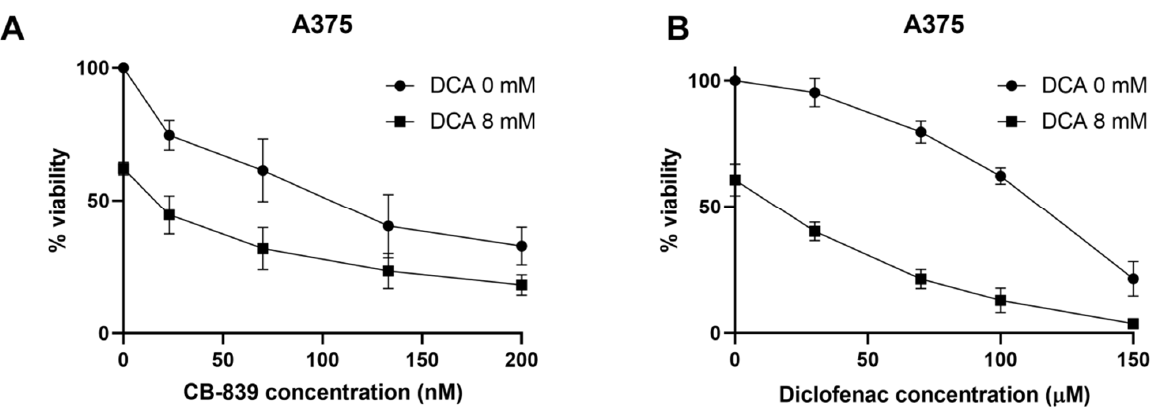
Figure 5. DCA shows synergy with other metabolic inhibitors. ( A ) Viability curve of A375 cells after 96 h of treatment with CB ‐ 839 with and without DCA. ( B ) Viability curve of A375 cells after 96h of treatment with diclofenac with and without DCA. Data represent mean ± SD of 3 independent experiments, each performed in triplicate.